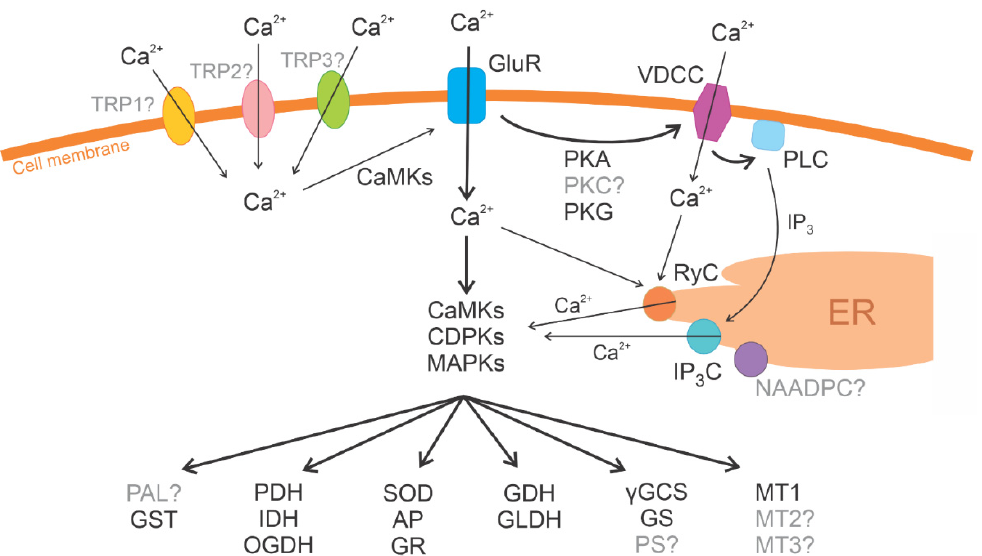
Figure 2. Scheme of Protein-coding genes in the U. compressa genome: superoxide dismutase (SOD), ascorbate peroxidase (AP), glutathione reductase (GR), and peroxiredoxin (PRX); L-galactono-lactone dehydrogenase (L-GLDH), L-galactose dehydrogenase, glutamate-cysteine synthase (GCS), and glutathione synthase (GS); metallothioneins UcMT1, UcMT2, and UcMT3; phenylalanine ammonia lyase (PAL); pyruvate dehydrogenase (PDH), isocitrate dehydrogenase (IDH), and 2-oxoglutarate dehydrogenase (OGDH); mitogen-activated protein kinases (MAPKs); calcium-dependent protein kinases (CDPKs); calcineurin B-like protein kinases (CBLPKs) and calcium/calmodulin protein kinases (CaMKs); transient receptor potential (TRP) channels, voltage-dependent calcium channels (VDCCs), phospholipase D (PLD), calcium/ryanodine-dependent channel (RyC), IP3-dependent channel (IP3C), NAADP-dependent channel (NAADPC), and ionotropic glutamate receptors (GluR); cAMP-dependent protein kinase (PKA) and cGMP-dependent protein kinase (PKG). Those proteins that have been identified in the U. compressa genome and have also been experimentally detected are depicted in black, and those that have been experimentally detected and are not present in the U. compressa genome are depicted in gray with a question mark.